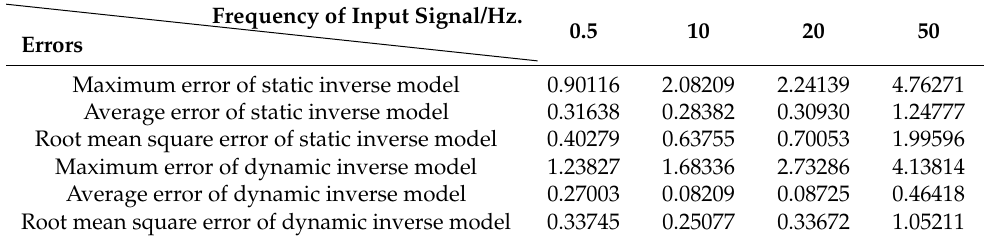
Table 3. Errors of the hysteresis inverse model under different excitation signal frequencies.